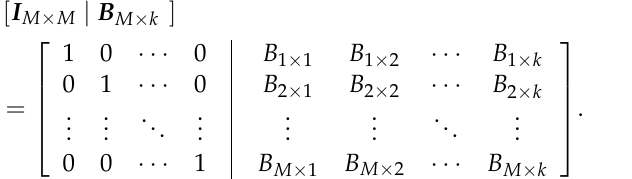
Algorithm 2 (GDA) optimizes the P-LDPC codes from scratch and uses the principle of degree balance to generate new codes suitable for equal-probability Bernoulli sources by global degree allocation. The initial structure of the proposed P-LDPC codes is shown in Equation (23), which could make the partition of the quantization subspace by the P-LDPC codes concentrated in B M × k . Algorithm 2 can make the error correction range of each variable node as equal as possible by filling the total degree into B M × k , so that 2 k quantized subspaces are further uniformly divided. By doing so, the quantization distortion D S is reduced. In addition, P-LDPC codes with various rates could be obtained from Algorithm 2, by arbitrarily setting the dimension of the identity matrix and the number of variable nodes in Equation (23). Note that in Equation (23), I M × M denotes the identity matrix, and B M × k is the matrix to be